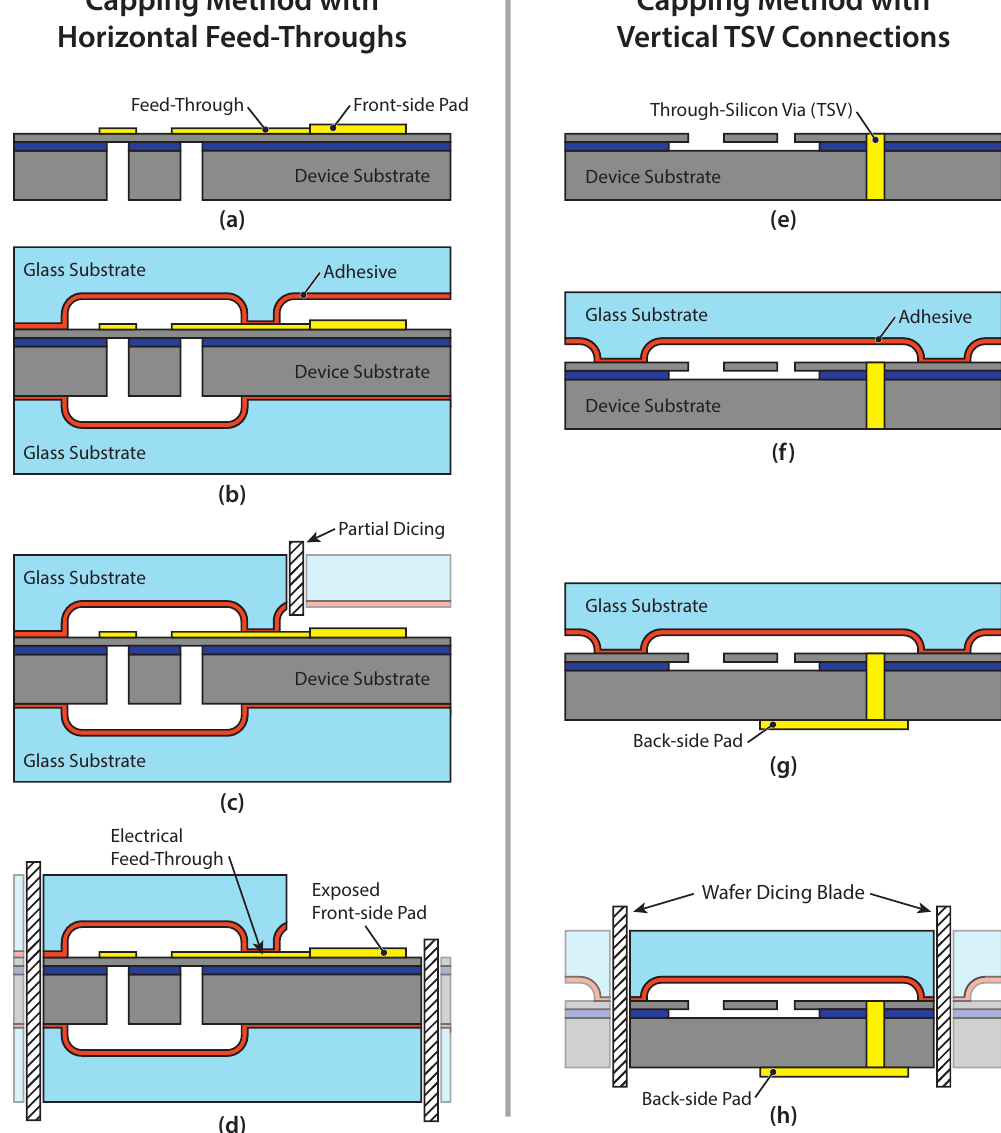
Figure 2. Capping process demonstrated for two different electrical interconnection schemes. ( a – d ) Front and back-side capping with horizontal electrical feed-throughs. Partial dicing is used to reveal the pads. Suitable, for example, for wire bond integration; ( e – h ) Front-side capping with through-silicon vias (TSVs) providing a vertical connection through the device substrate. Suitable, for example, for flip-chip